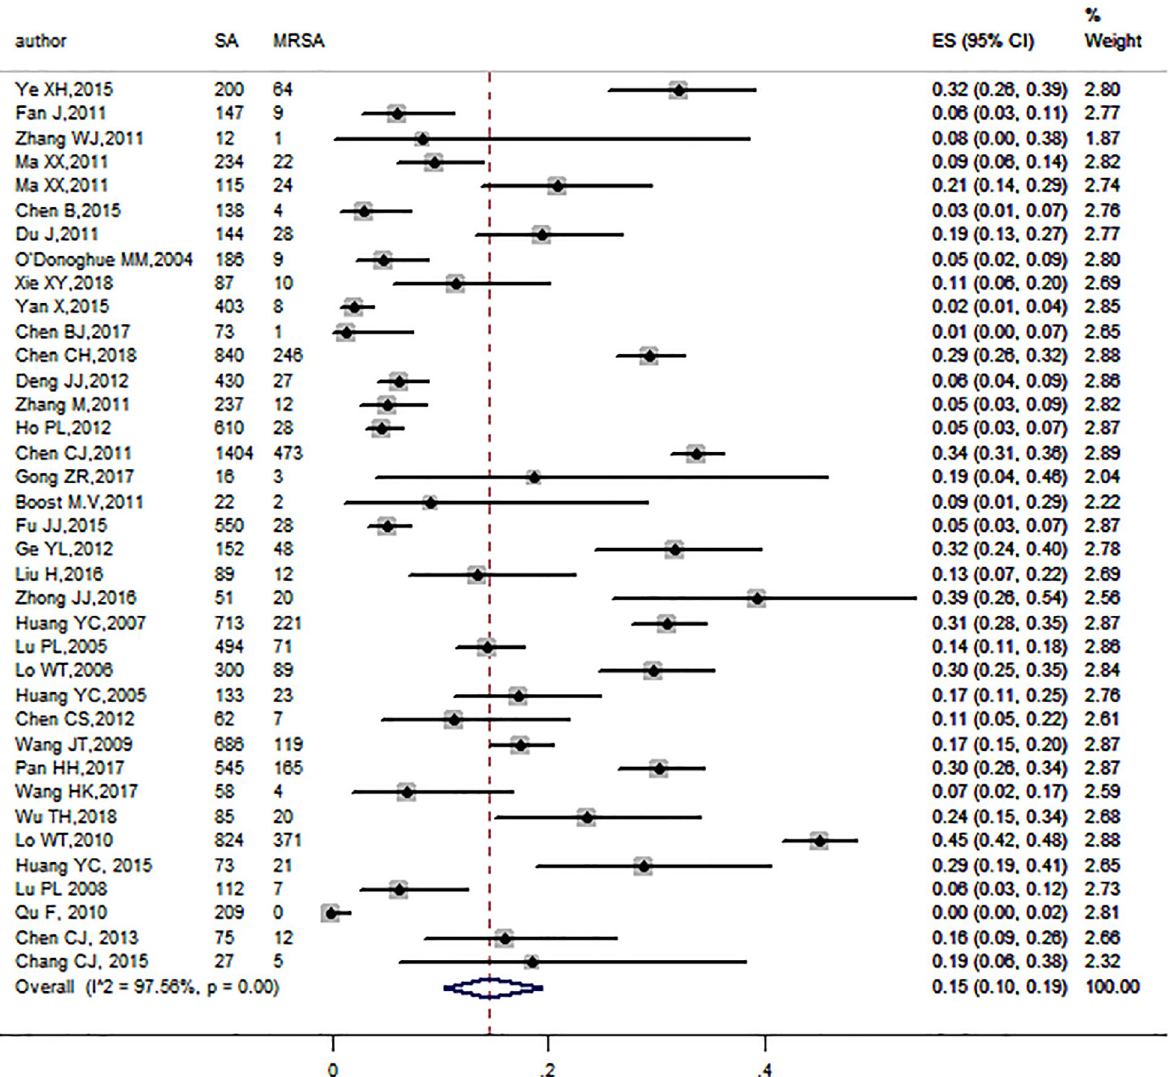
Fig 4. Forest plot of the pooled prevalence of